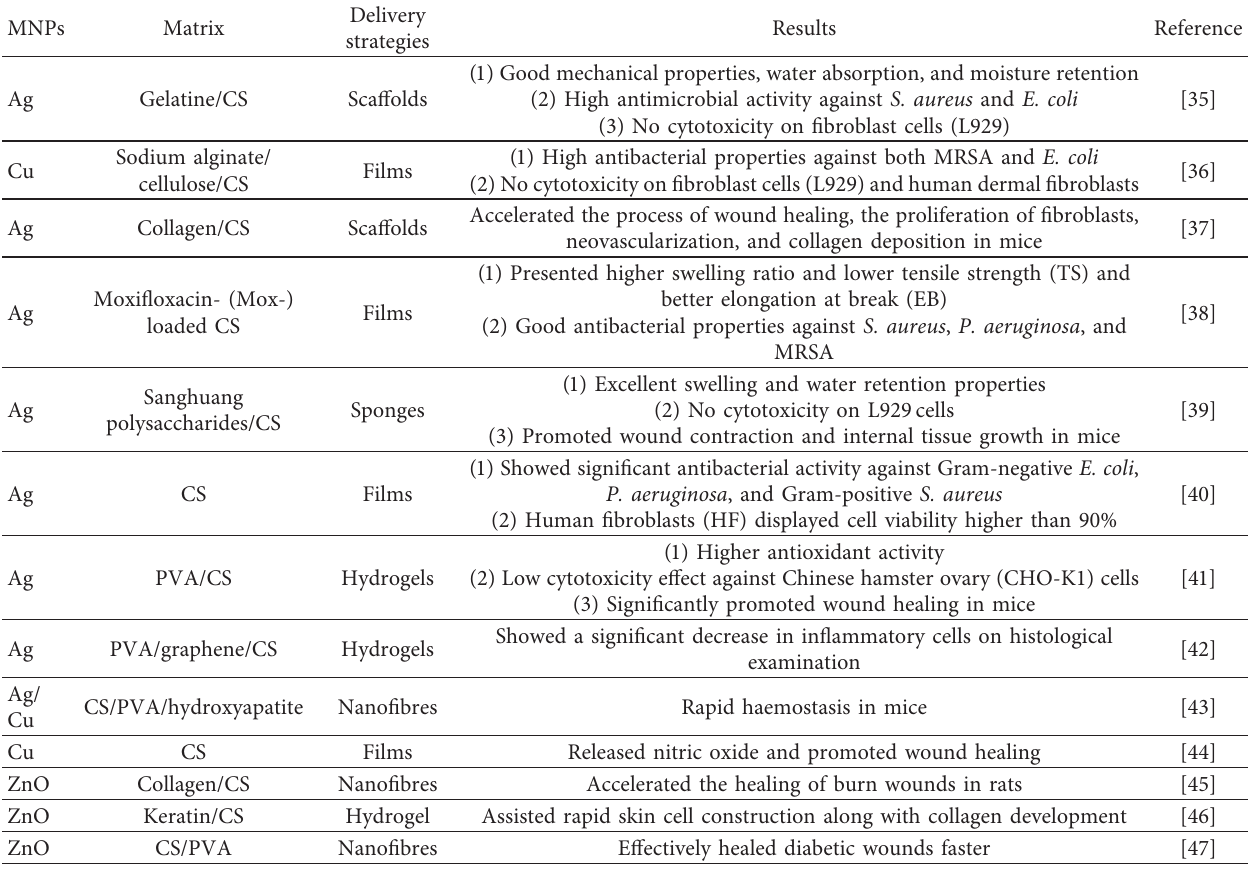
Table 1: The application of chitosan-based nanocomposites in wound healing in recent